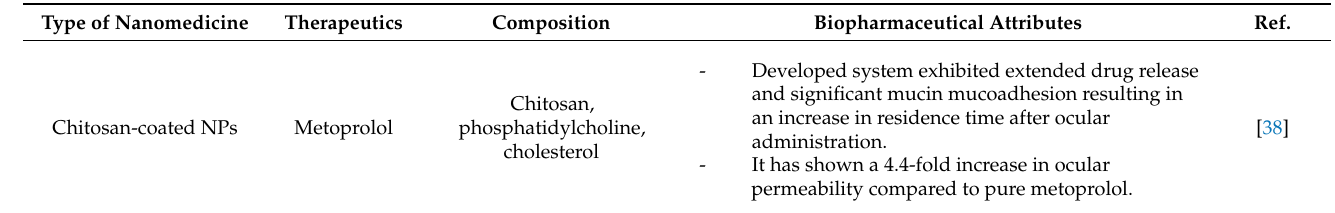
Table 2. Chitosan-based nanomedicine utilized to improve the biopharmaceutical attributes of loaded